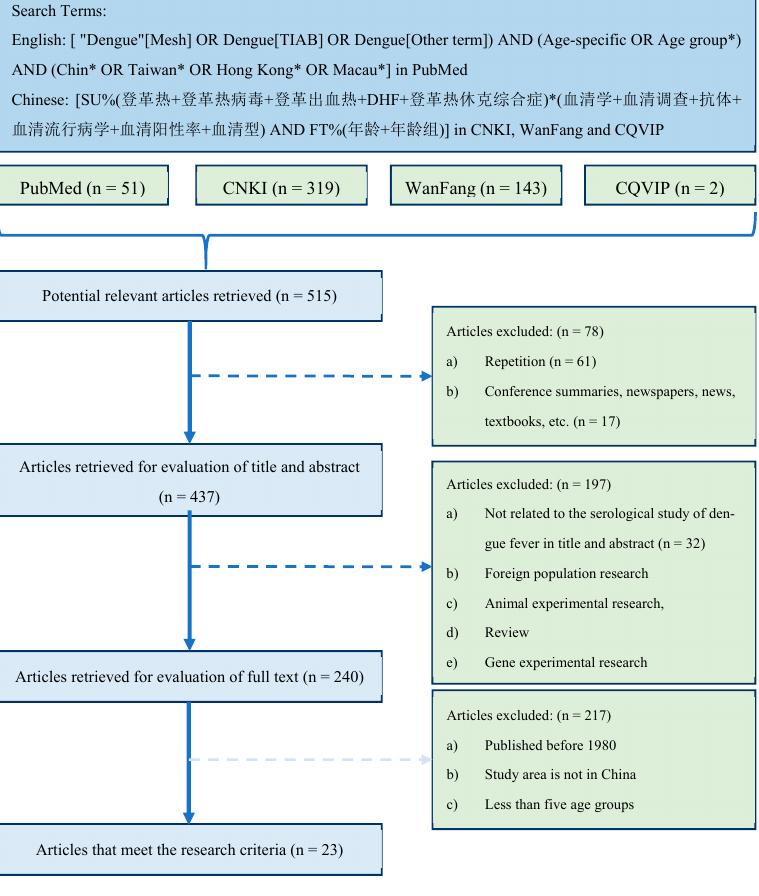
Figure 1. Literature search and screening process. Notice: (1) In the search query [ ”Dengue”[Mesh] OR Dengue[TIAB] OR Dengue[Other term]) AND (Age‑specific OR Age group*) AND (Chin* OR Taiwan* OR Hong Kong* OR Macau*], *, an asterisk, is the truncation symbol in PubMed,